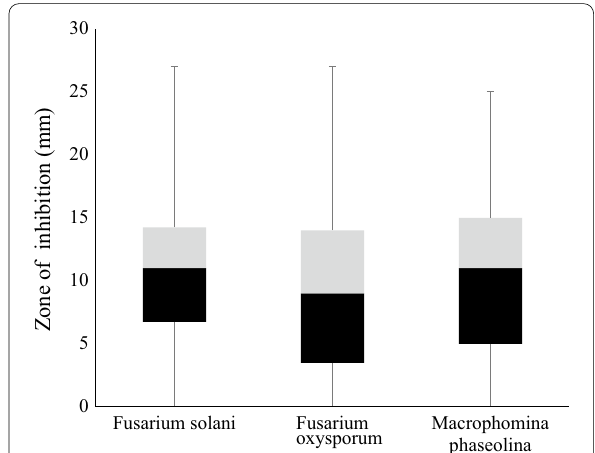
Fig. 2 Box‑and‑Whisker plot for inhibition of three fungal species. It shows median (middle line in the box), upper quartile (end of black box), lower quartile (end of gray box), maximum and minimum values